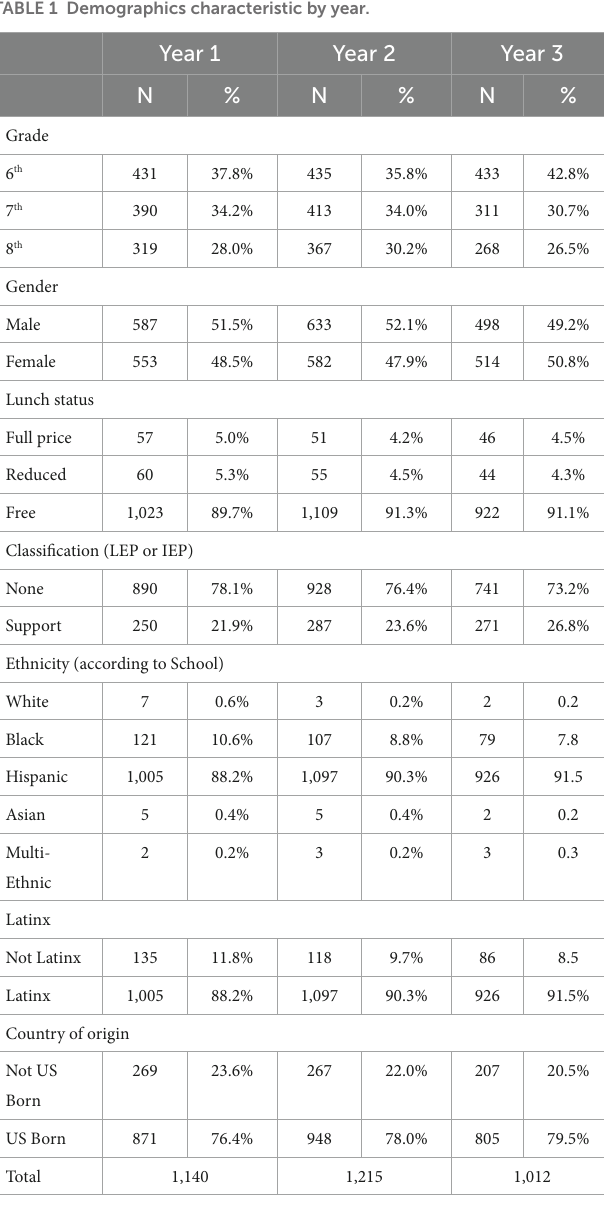
TABLE 1 Demographics characteristic by